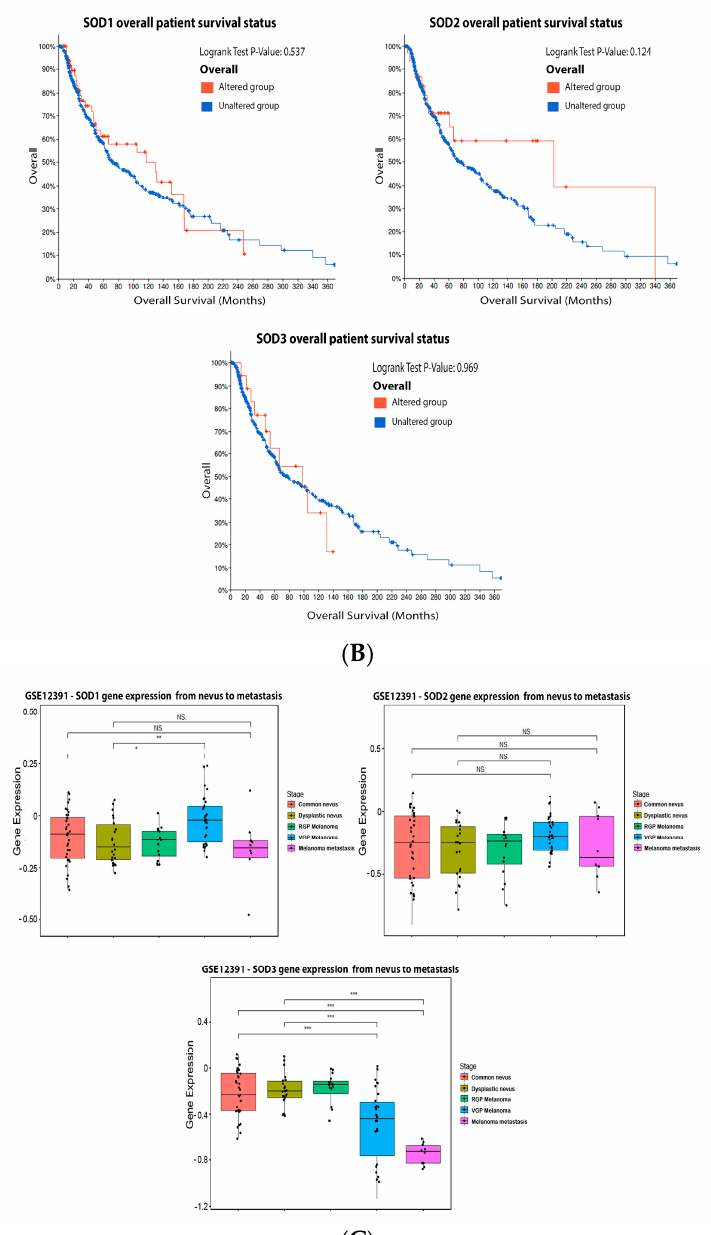
Figure 3. Superoxide dismutase on melanoma. ( A ) Percentage of patients with altered genes and types of genetic alterations; ( B ) overall patient survival status, and ( C ) expression in melanoma progression. Red boxes are common nevus, yellow boxes are dysplastic nevus, green boxes are radial growth phase (RGP) melanoma, blue boxes are vertical growth phase (VGP) melanoma, and purple boxes are metastatic melanoma. The statistical analysis was performed by ANOVA followed by Tukey test, *** p < 0.001, ** p < 0.01, * p < 0.05 when compared to common or dysplastic nevus. NS: Not